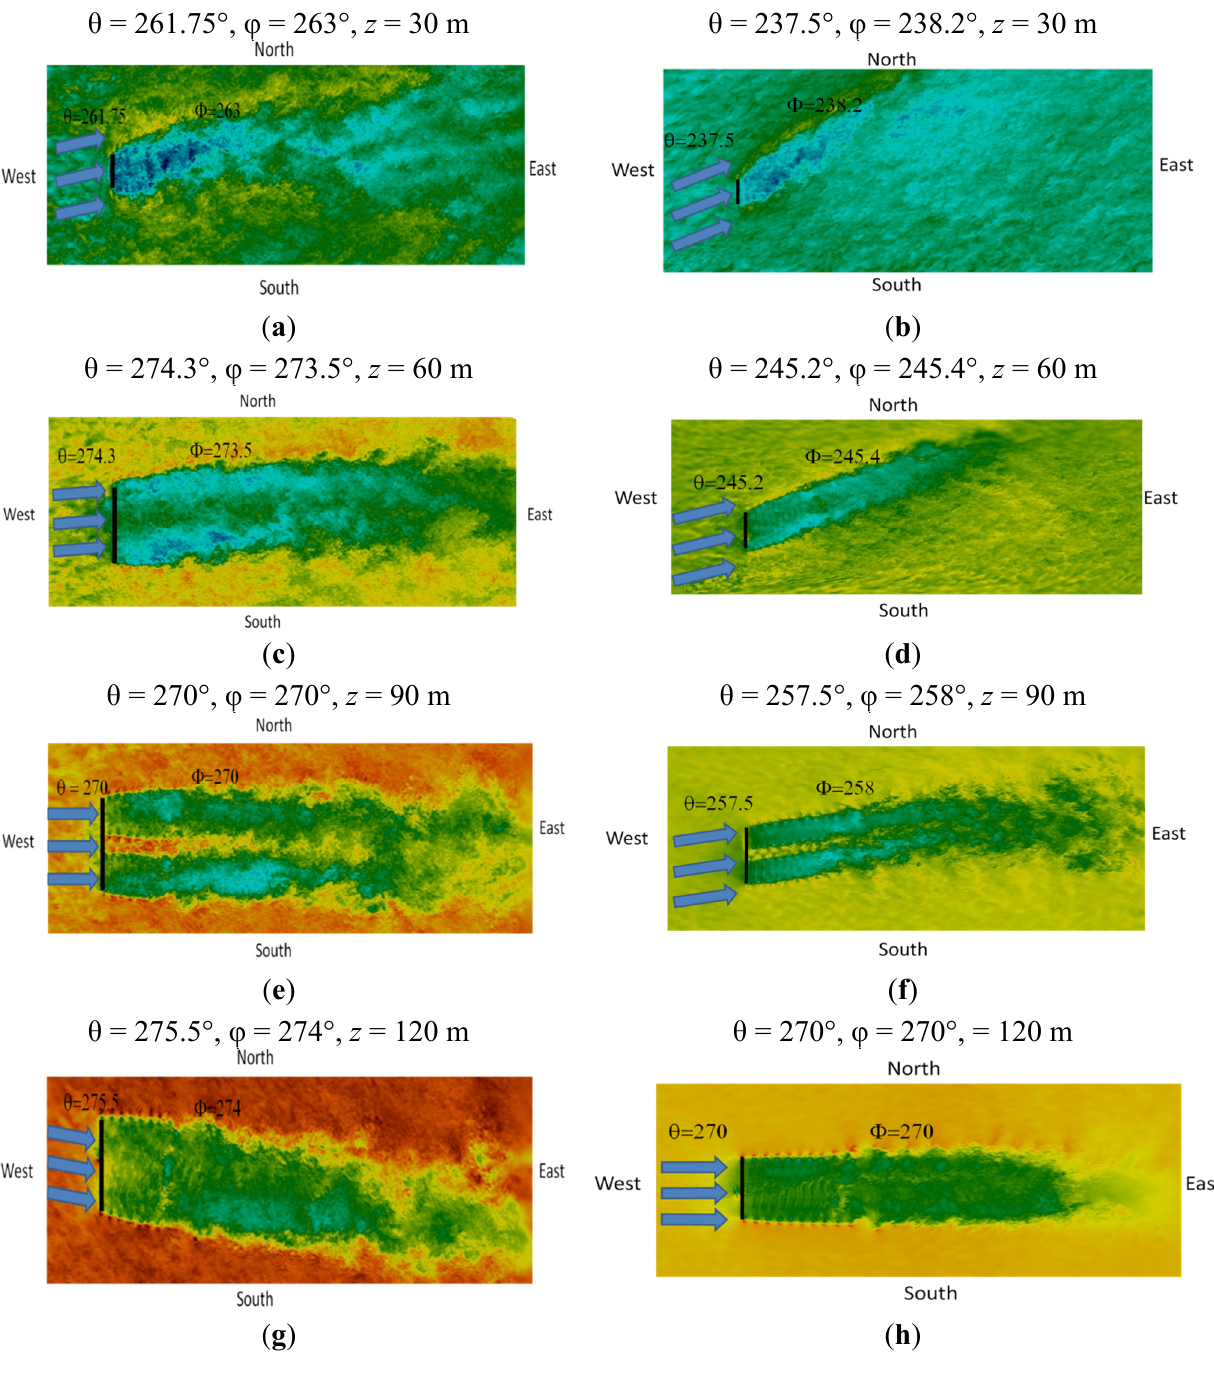
Figure 11. Velocity in the horizontal plane at heights corresponding to ( a , b ) z = 30 m; ( c , d ) z = 60 m; ( e , f ) 90 m; ( g , h ) 120 m; and ( i , j ) z = 150 m. (Left): low-stratified ABL and (Right): moderately-stratified ABL regimes. Shown are the wind angle and the resultant wake angle with respect to the WT.